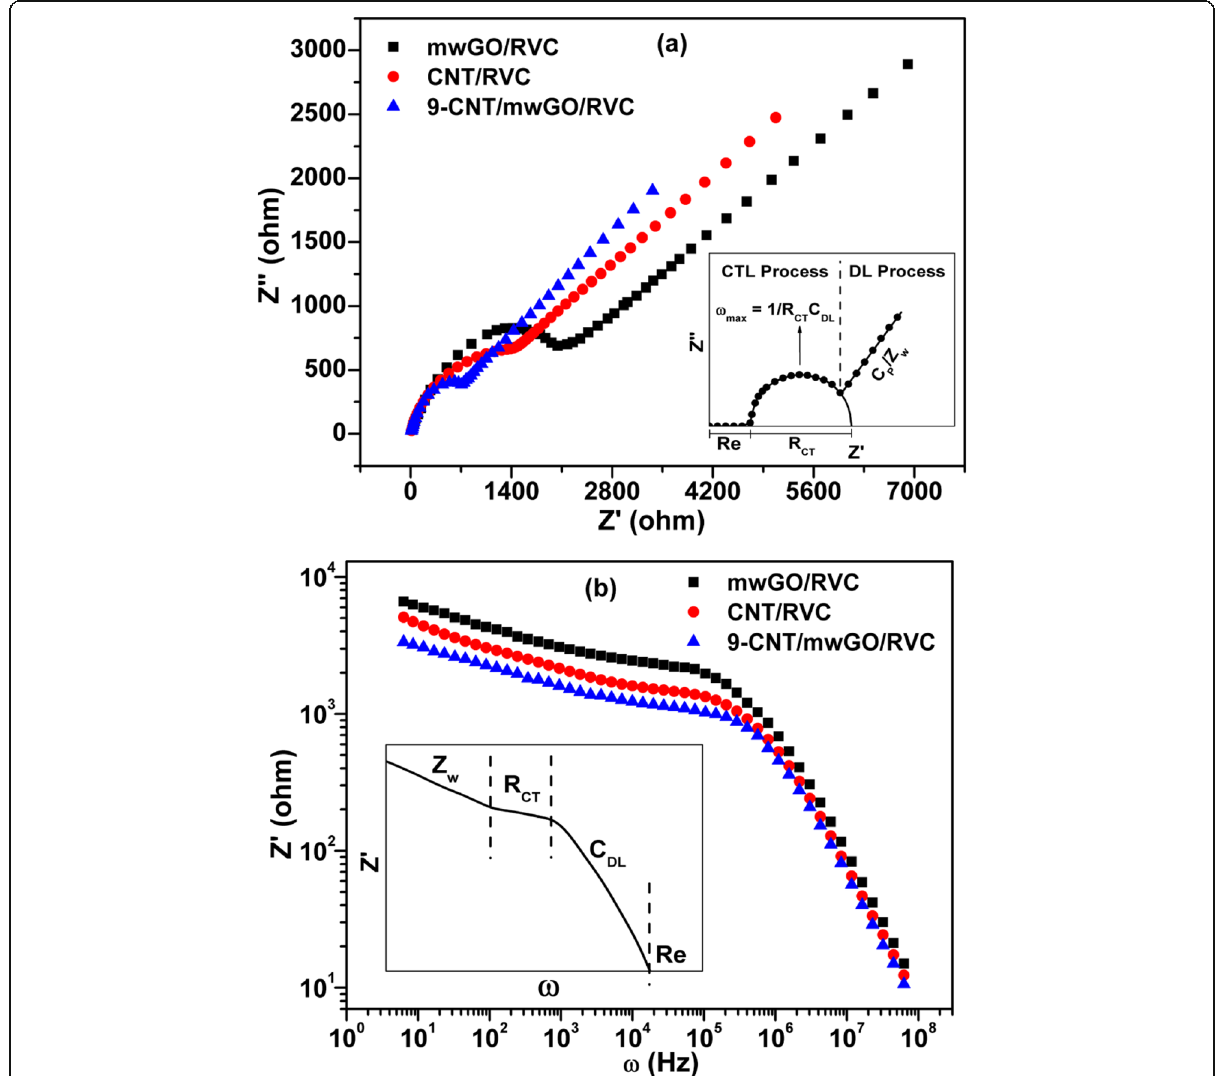
Fig. 5 a Nyquist plot (inset diagram) and b Bode plot of mwGO/RVC, CNT/RVC, and 9-CNT/mwGO/RVC composite